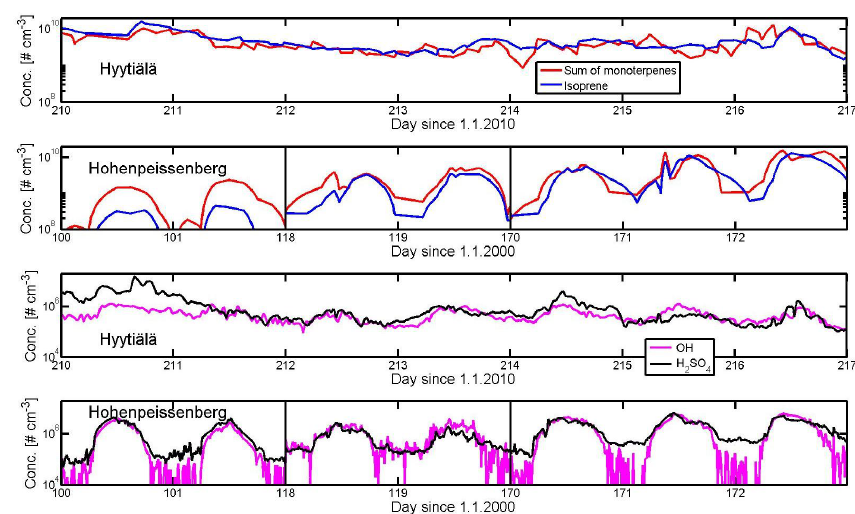
Fig. 3. Measured concentrations of different organic vapours, hydroxyl radicals and sulfuric acid for the selected periods at both stations.